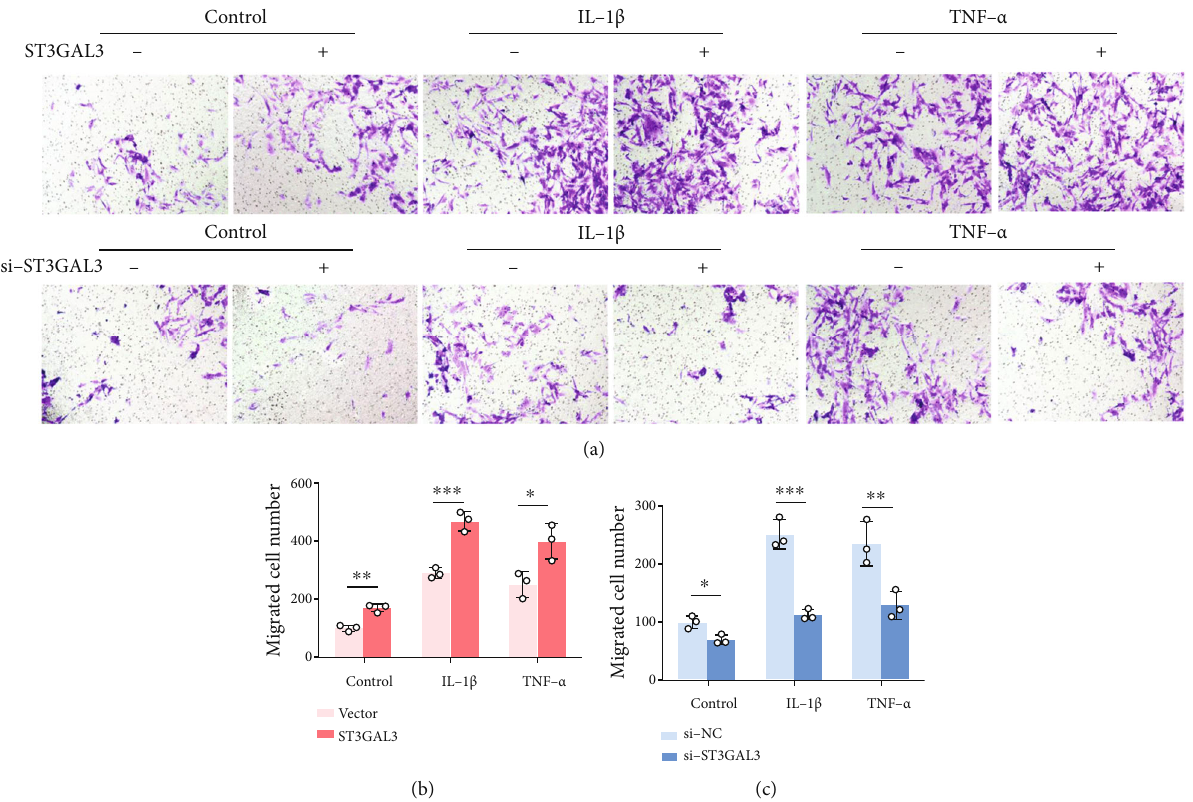
Figure 3: ST3GAL3 promoted the migration of MH7A cells. (a) Representative images of cell migration from transwell assay. (b) Transwell results showed that ST3GAL3 overexpression promoted cell migration, (c) while si-ST3GAL3 inhibited cell migration. n = 3 . ∗ p < 0 : 05 , ∗∗ p < 0 : 01 , and ∗∗∗ p < 0 : 001 compared with the indicated